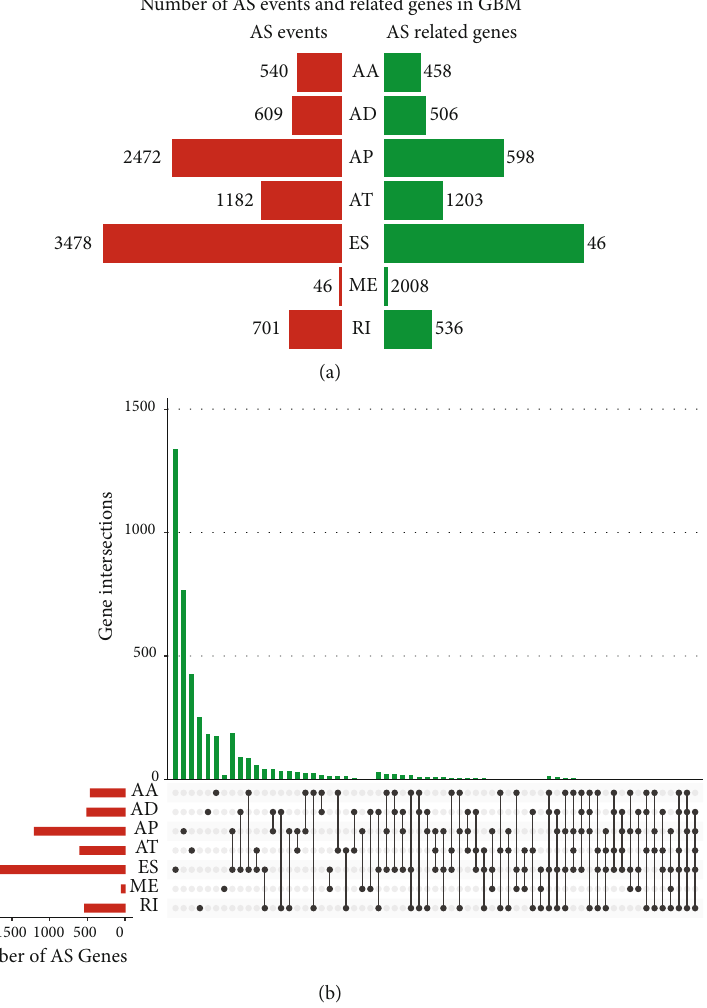
Figure 1: AS events in glioma: (a) various types of AS events and the number of genes involved; (b) UpSet diagram of the overall AS events involving interactions between